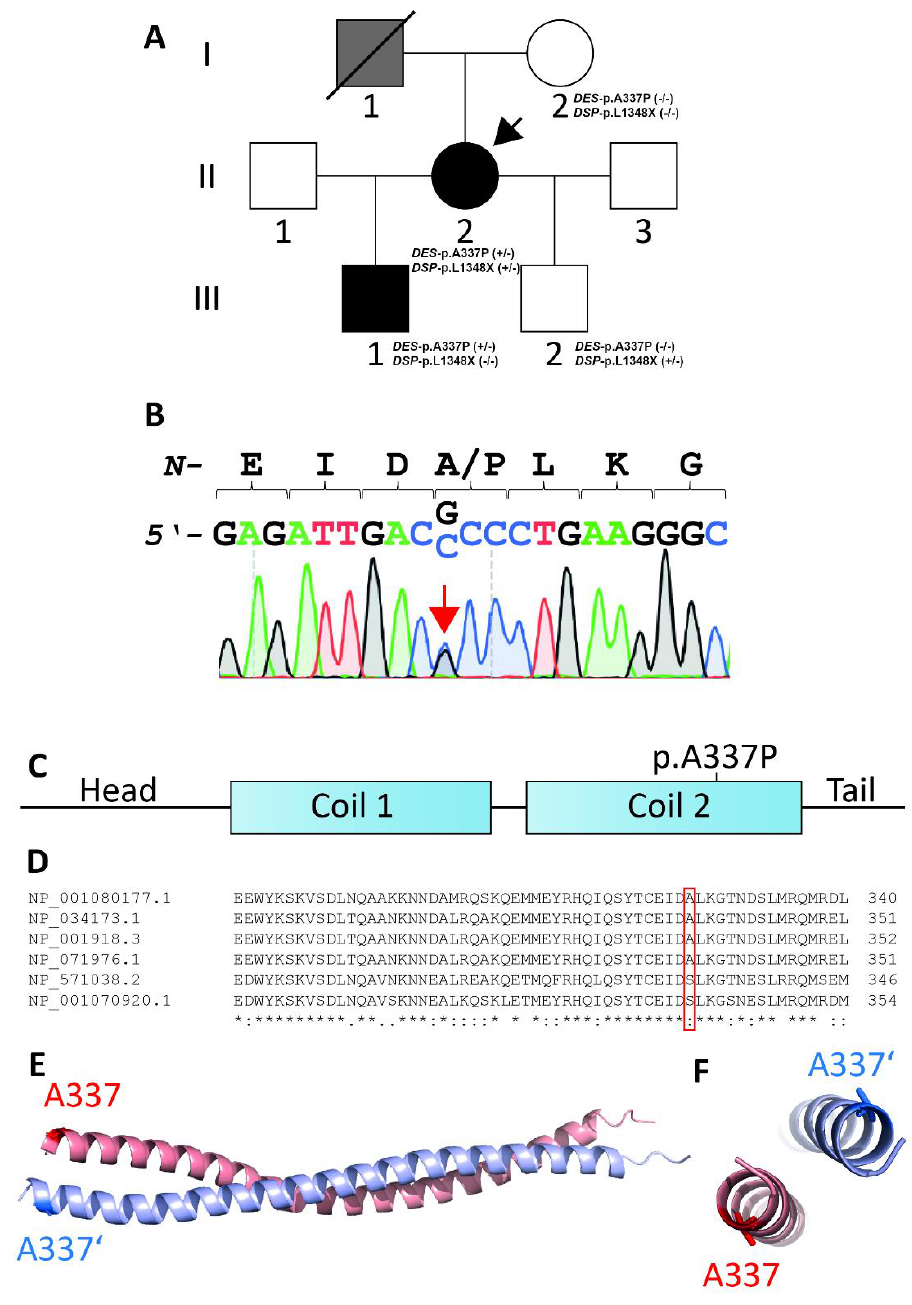
Figure 1. ( A ) Pedigree of the family. Circles represent females, squares males, slash denotes deceased. Black-filled symbols indicate a cardiac phenotype, grey-filled symbols indicate individuals with suspected cardiomyopathy, and white symbols indicate healthy family members. +/− or −/− indicates heterozygous or wild-type DES -p.A337P and DSP -p.L1348X variants, respectively. The index patient (II-2) is marked with an arrow. ( B ) Electropherograms of DES -p.A337P (c.1009G>C) in the genome of the index patient (II-2) and her son (III-1). ( C ) Schematic domain structure of desmin. DES -p.A337P is localized in the coil-2 sub-domain. ( D ) Multiple species alignment of desmin from Xenopus laevis (NP_001080177.1), Mus musculus (NP_034173.1), Homo sapiens (NP_001918.3), Rattus norvegicus (NP_071976.1), and Danio rerio (NP_571038.2, NP_001070920.1). ( E , F ) Desmin dimer, modeled using Swiss-Model (PDB ID: 3TRT [27]). Mutant alanine residues (p.A337 and p.A337 (cid:48) ) are highlighted in blue and red. Of note, both alanine residues are localized at the opposite sites of the desmin